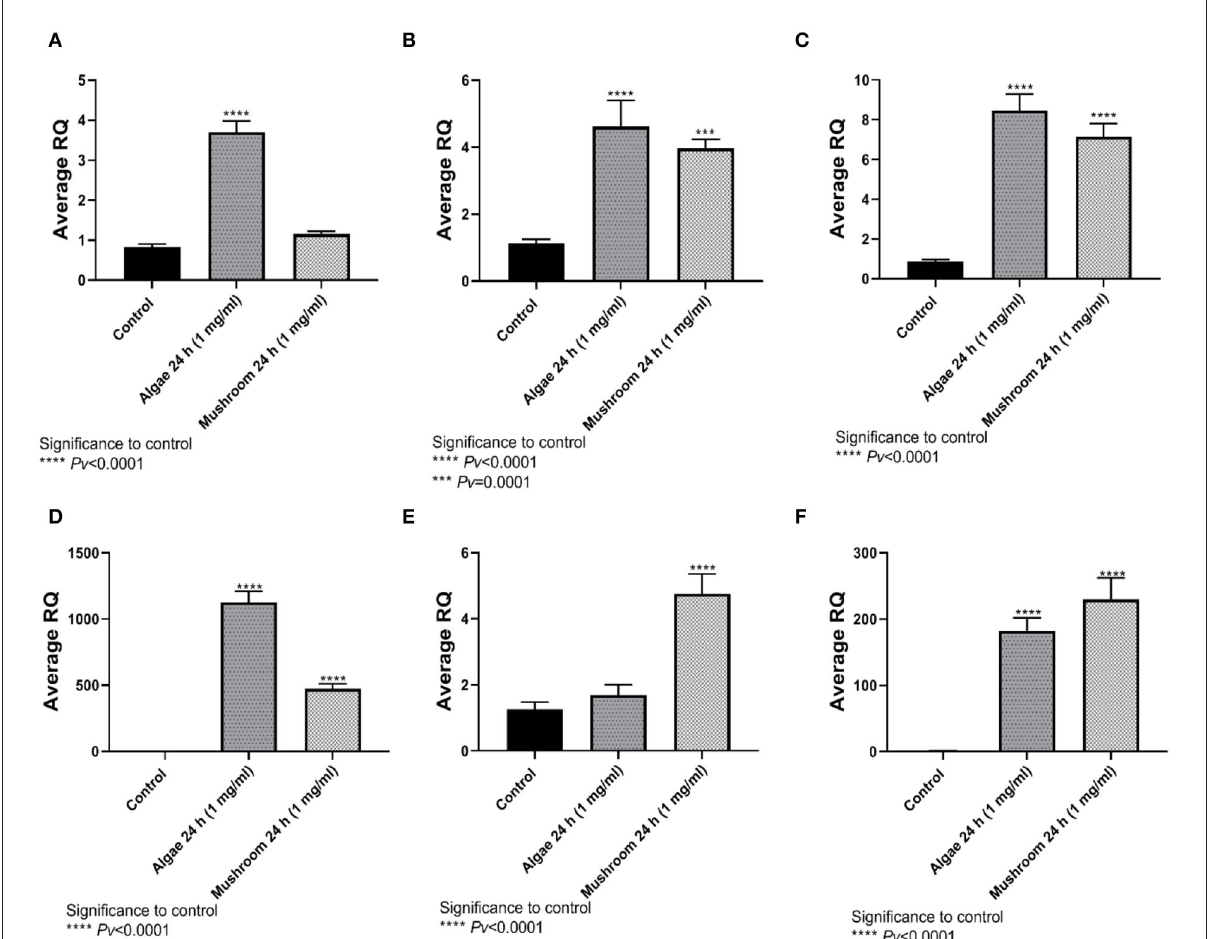
FIGURE4 Gene expression after 24h incubation with Algea or Mushroom glucans. (A) Tnf α , (B) IL4, (C) IL6, (D) IL8, (E) IL10, (F) iNOS 2 compared to the control group using the relative fold gene expression (DDCT) (n = 5).